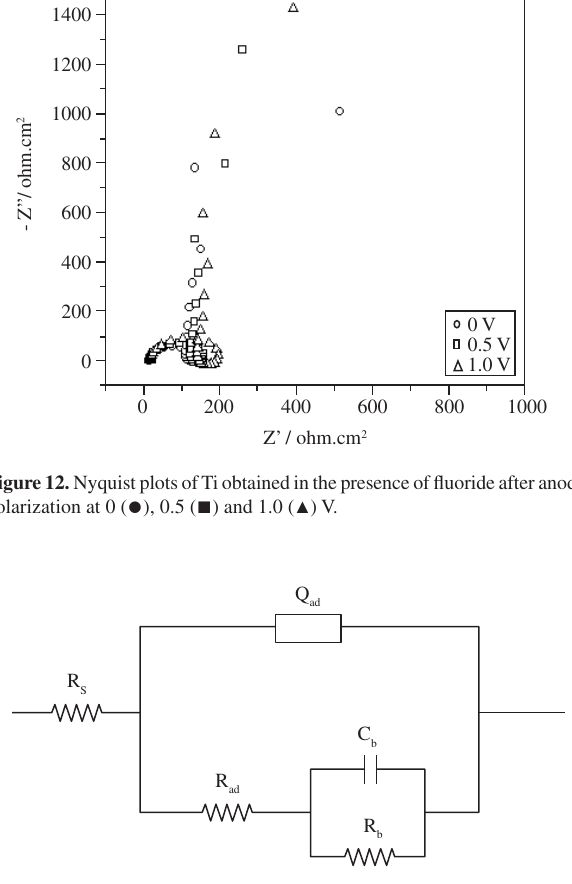
Figure 13. Equivalent circuit obtained from fitting and simulation of Bode plots in Figure 7.